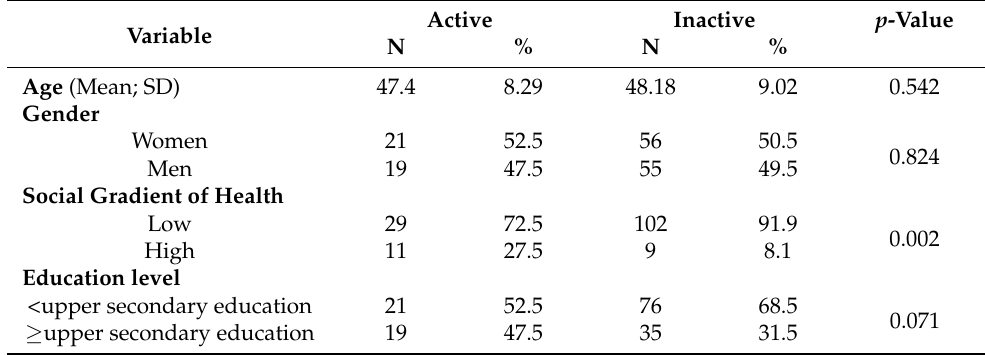
Table 2. Correlation between professional situation and sociodemographic variables.